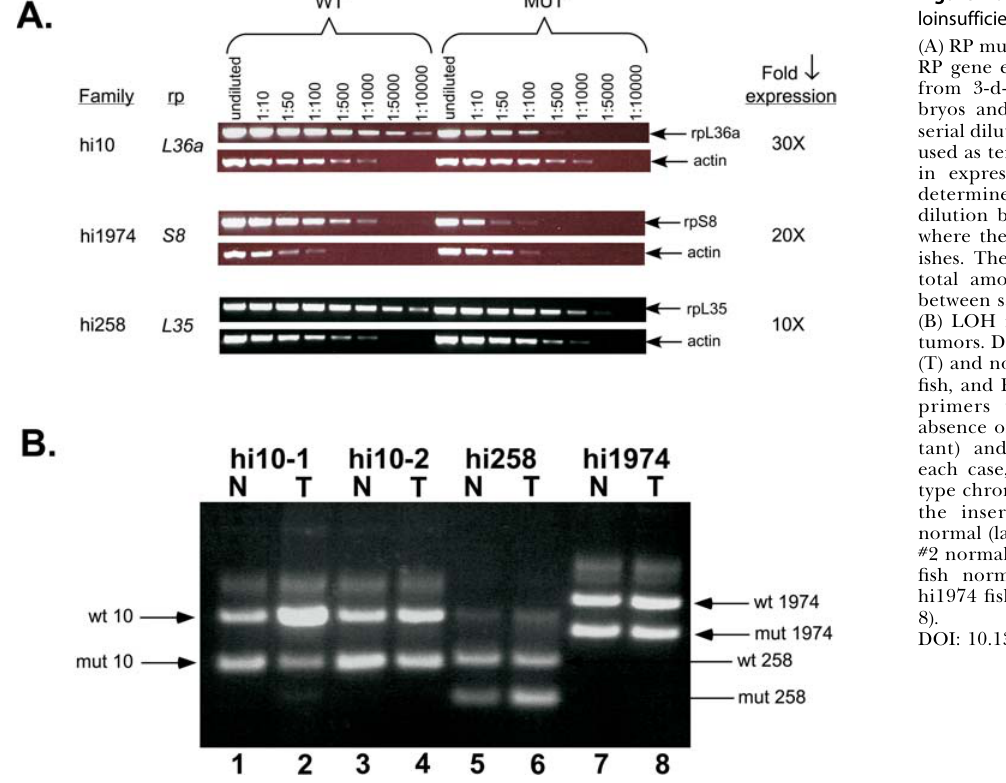
Figure 4. RP Genes Appear to Be Hap- loinsufficient Tumor Suppressors (A) RP mutations decrease the amount of RP gene expression. RNA was prepared from 3-d-old homozygous mutant em- bryos and their wild-type siblings, and serial dilutions of first strand cDNA were used as templates for PCR. The decrease in expression in the mutants can be determined by the difference in the dilution between wild type and mutant where the PCR product amount dimin- ishes. The actin control shows that the total amount of mRNA was the same between samples. (B) LOH is not observed in RP mutant tumors. DNA was prepared from tumors (T) and normal tissue (N) from the same fish, and PCR was conducted with three primers that show the presence or absence of both the insert-bearing (mu- tant) and wild-type chromosomes. In each case, the upper band is the wild- type chromosome and the lower band is the insert-bearing one. hi10 fish #1 normal (lane 1), tumor (lane 2); hi10 fish #2 normal (lane 3), tumor (lane 4); hi258 fish normal (lane 5), tumor (lane 6); hi1974 fish normal (lane 7), tumor (lane